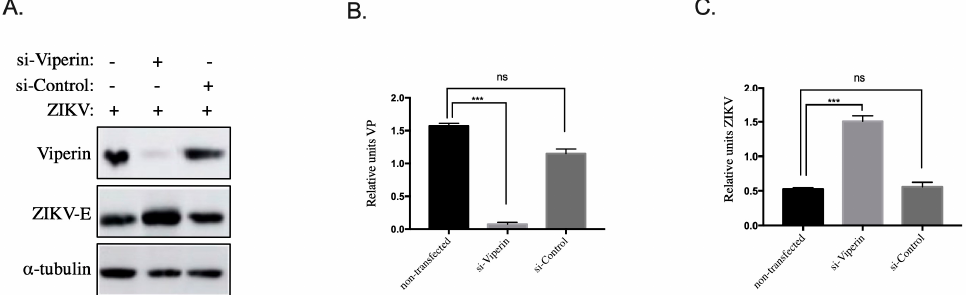
Figure 3. Overexpression of endogenous viperin in HK-2 HGC cells suppresses ZIKV infection. ( A ) HK- 2 HGC cells were transfected with siRNA-VP (si-Viperin) or scrambled siRNA (si-Control) for 24 h and then infected with ZIKV GFP at a MOI of 1 for another 24 h. Immunoblots show viperin (VP) and ZIKV- E proteins, as well as α -tubulin as loading control. Viperin protein and ZIKV-E quantification in ( B , C ), respectively, were performed by normalizing to tubulin from the results obtained in ( A ). Data are representative of at least three independent experiments. Results are shown as means ± SD. Unpaired t-test shows that differences are either non-significant (ns) or statistically significant (*** p < 0.001). Taken together, these results on viperin overexpression in HK-2 NGC and